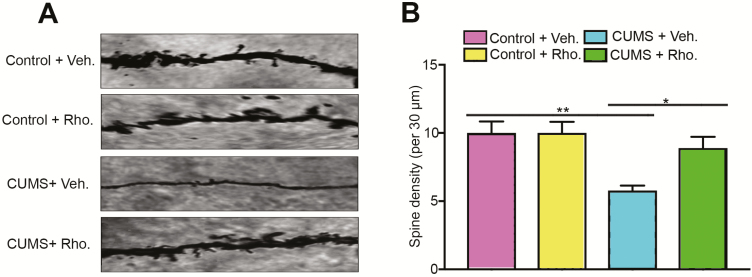
Decrease in dendritic spine number of hippocampal CA1 pyramidal cells in chronic unpredictable mild stress (CUMS) mice was protected by rhodomyrtone treatment. (A) Hippocampus CA1 dendrite spine number was assessed by Golgi staining in all groups. (B) Quantification of spine density all groups; 5 neurons per mouse were analyzed. n=9 for all groups; data are presented as mean±SEM; *P<.05; **P<.01; ***P<.001.